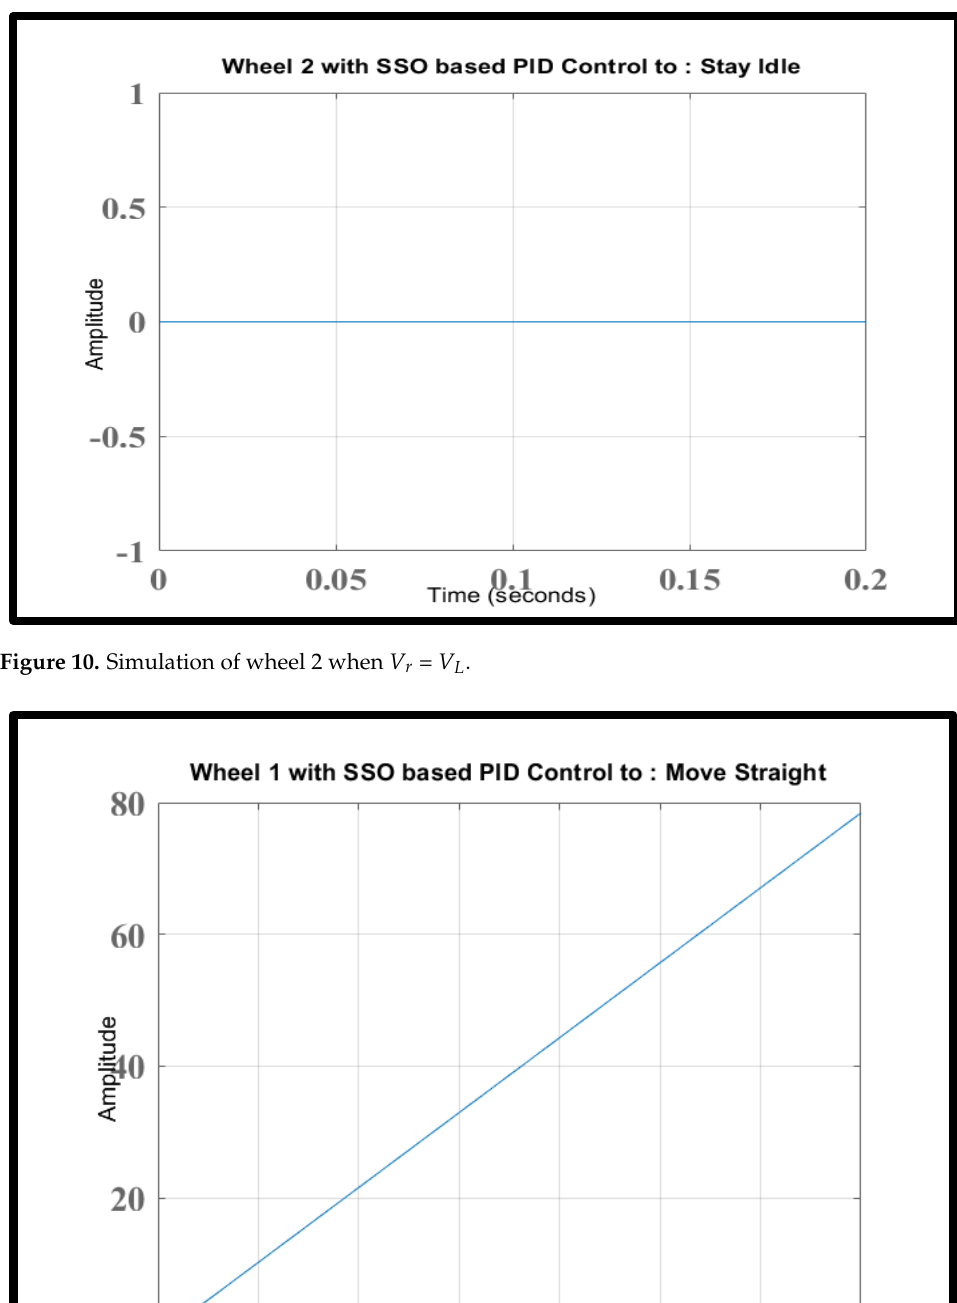
Figure 9. Simulation of wheel 1 when V L = V r .